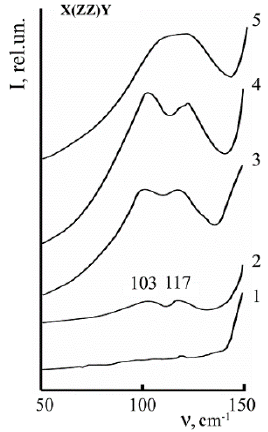
Figure 19. Fragments in the region of 100 – 150 cm − 1 of Raman spectra of different LN single crystals: 1 - SLN; 2 - stoichiometric LiNbO 3 : Gd 3+ (0.001 wt.%); 3 - CLN; 4 - congruent LiNbO 3 :Mg 2+ (0.36 wt.%); 5 - congruent LiNbO 3 :Gd 3+ : Mg 2+ (0.25; 0.75 wt.%). T = 293 K.